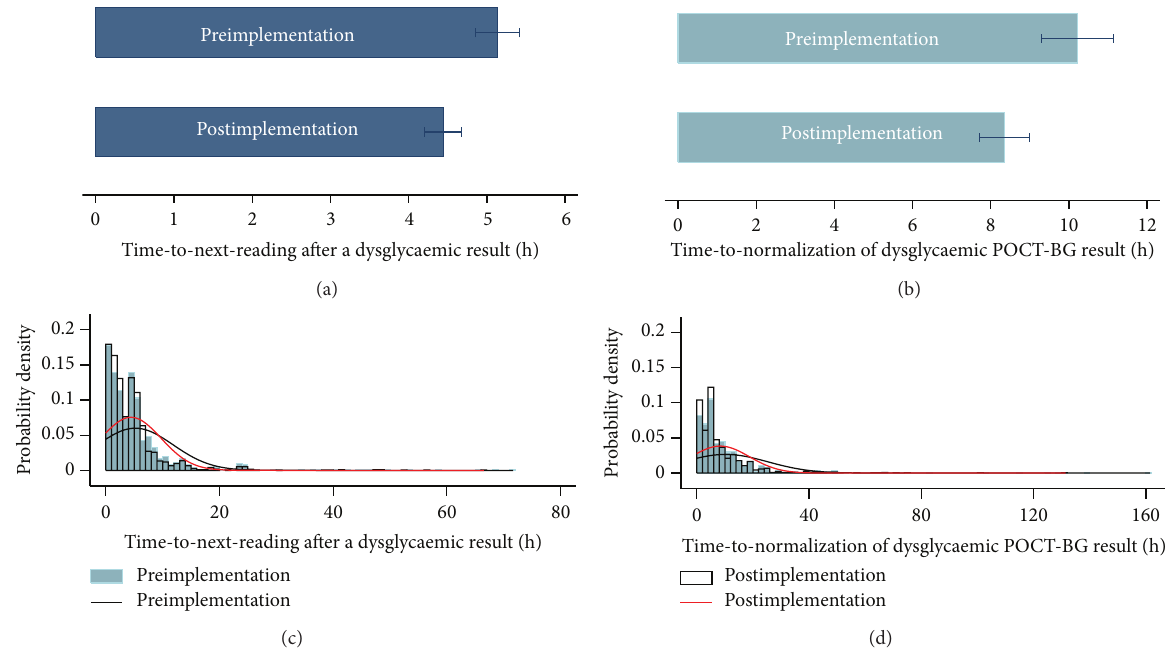
Figure 4: Bar graphs showing mean and 95% CI of (a) time-to-next-reading after dysglycaemic results and (b) time-to-normalization of a dysglycaemic result, before and after implementation. Histograms with probability density plots of (c) time-to-next-reading after a dysglycaemic result and (d) time-to-normalization of a dysglycaemic result, before and after implementation.